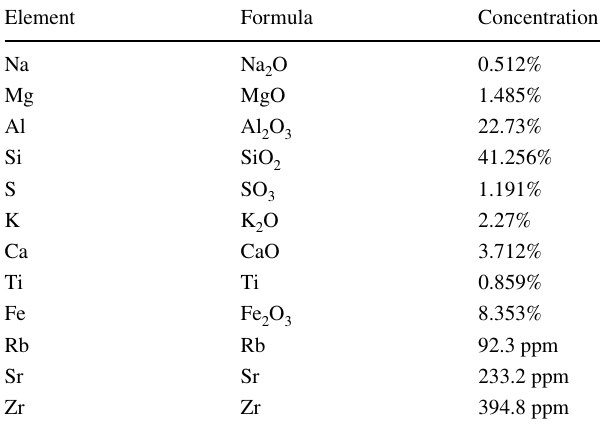
Fig. 3 Presence of microfractures Table 2 XRF analysis results Element